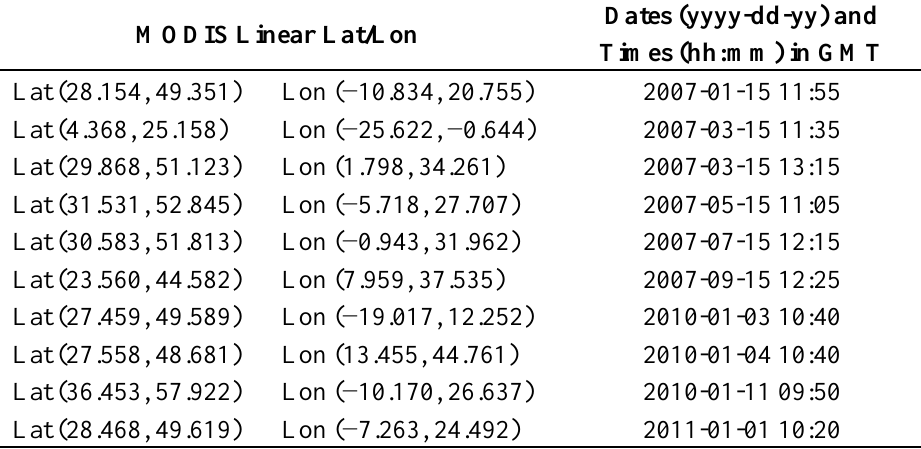
Table 2. List of MYD04/MOD04 data used for the determination of MSG dust-detection technique thresholds.